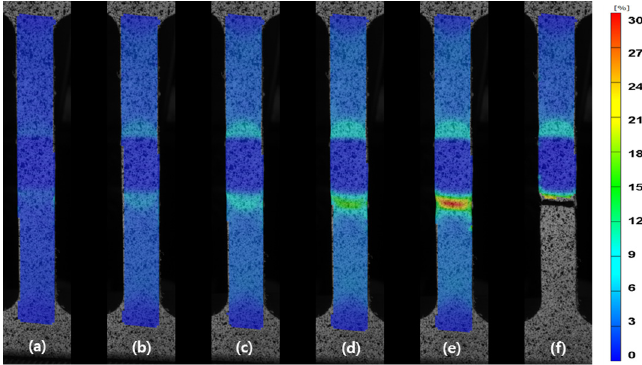
Figure 8. Strain maps resulting from the DIC measurement: ( a ) global strain = 1.0%; ( b ) global strain = 2.0%; ( c ) global strain = 3.0%; ( d ) global strain = 4.0%; ( e ) before failure; ( f ) after failure. Materials 2015 , 8 , page–page